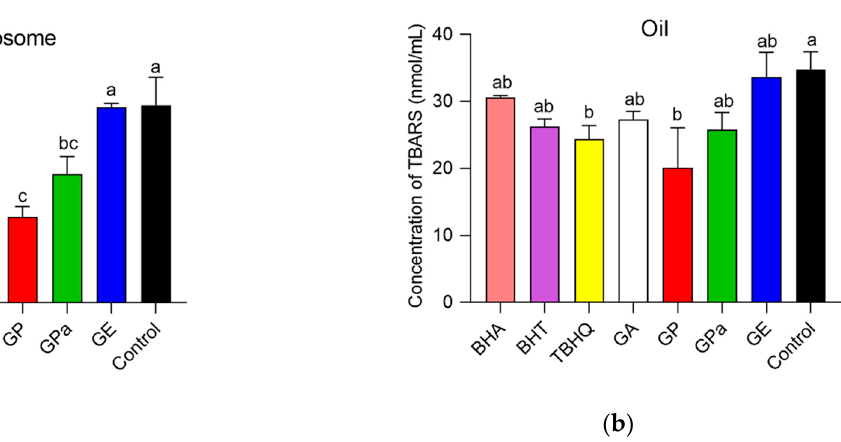
Figure 6. Concertation of thiobarbituric acid reactive substance (TBARS) in liposomal model ( a ) and glycerol trioleate bulk oil ( b ). Mean values with different letters are significantly different ( p < 0.05). Different lowercase letters represent a significant difference ( p < 0.05) between samples at same concentration.